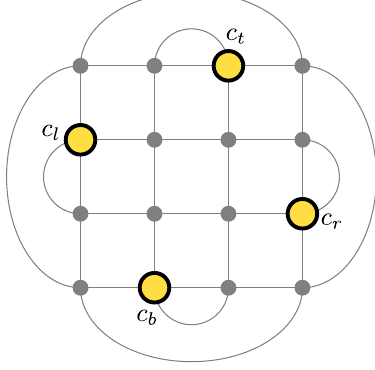
FIG. 4. The Ising fusion code uses a square graph with spherical boundary conditions. Four preferred code sites are highlighted. These sites were chosen to maximize the distance between them (and hence to maximize the code distance). We label them c t , c r , c b , and c l as